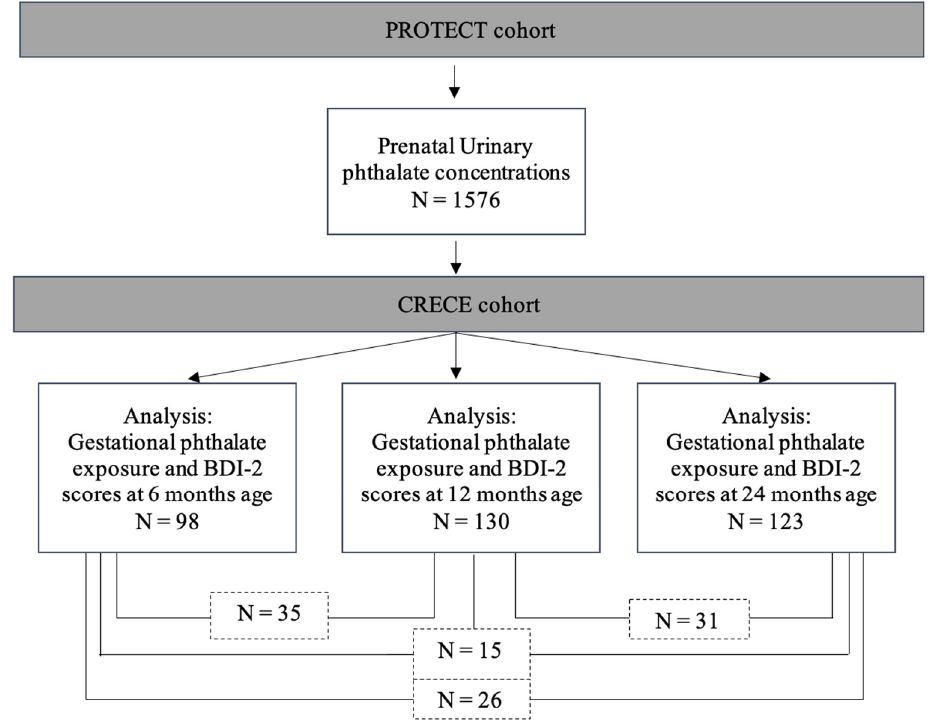
Figure 1. Analysis sample sizes. The present analysis included 274 participants with prenatal phthalate metabolite concentrations and childhood neurobehavioral assessments from at least one timepoint (age 6 months, 12 months, and/or 24 months). The dashed boxes below each analysis sample represent the number of participants with repeated assessment results.